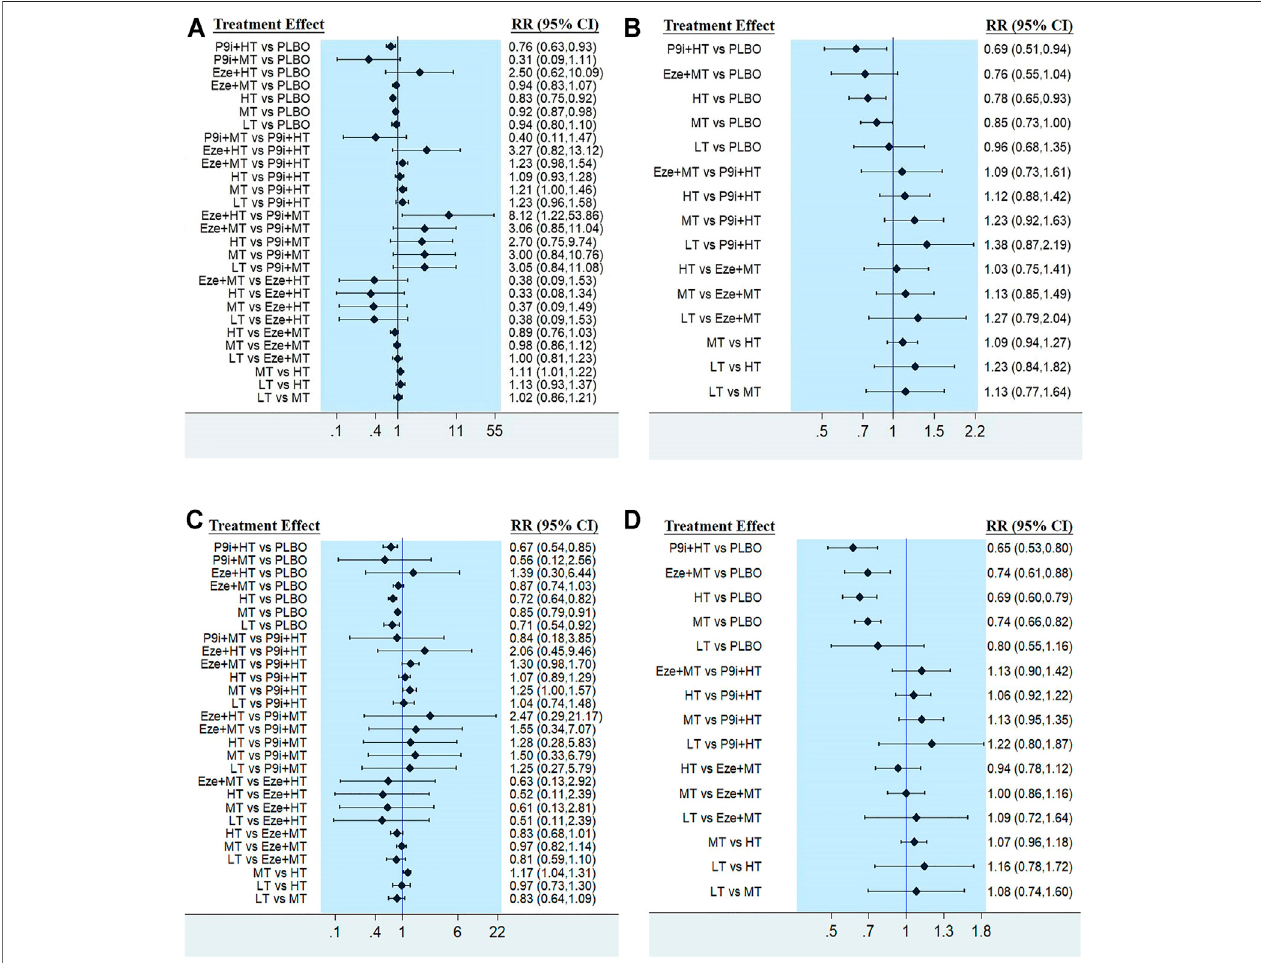
FIGURE 3 | Forest plots showing comparison among interventions for (A) All-cause mortality, (B) All-cause mortality of secondary prevention, (C) Cardiovascular mortality, (D) Cardiovascularmortalityofsecondaryprevention.PLBO,placebo;P9i+HT,PCSK9i+high-intensitystatins; P9i+MT,PCSK9i+moderate-intensitystatins; Eze+HT, ezetimibe + high-intensity statins; Eze+MT, ezetimibe + moderate-intensity statins; HT, high-intensity statins; MT, moderate-intensity statins; LT, low-intensity statins; RR, risk ratios; CI, con fi dence intervals.